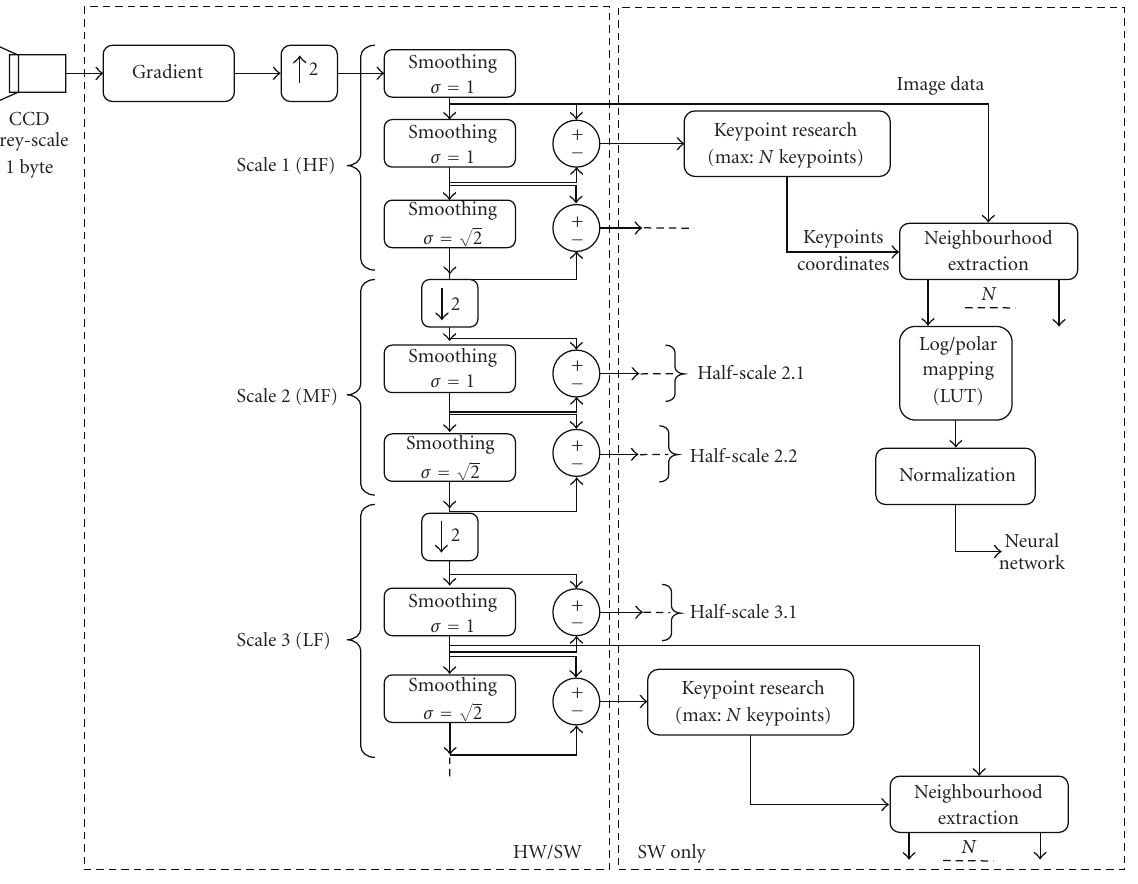
Figure 9: Global architecture of the robotic